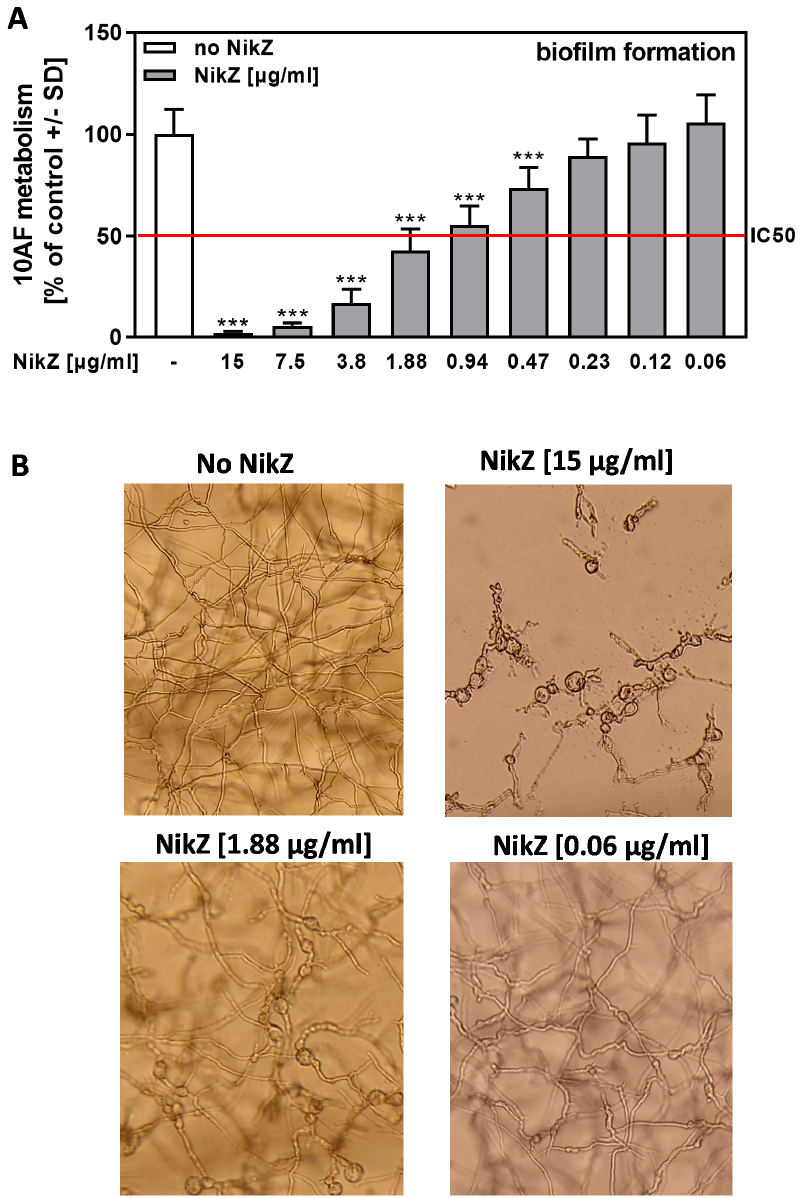
Figure 1. NikZ dose-dependently interferes with 10AF, forming biofilm metabolism and causes structural changes in hyphae. ( A ) The 10AF forming biofilm was incubated with NikZ (15 to 0.06 µ g/mL) at 37 ◦ C for 16 h. Aspergillus metabolism was measured by XTT assay. Metabolism in the presence of RPMI alone (white bar) was regarded as 100%. The red line represents the IC50. Comparisons: No NikZ (white bar) vs. each NikZ concentration (grey bars). Statistical analysis (n = 6): Unpaired t -test, three asterisks = p ≤ 0.001. Only significant differences are indicated. ( B ) Pictures were taken from wells described in A after 16 h of incubation at 37 ◦ C before XTT